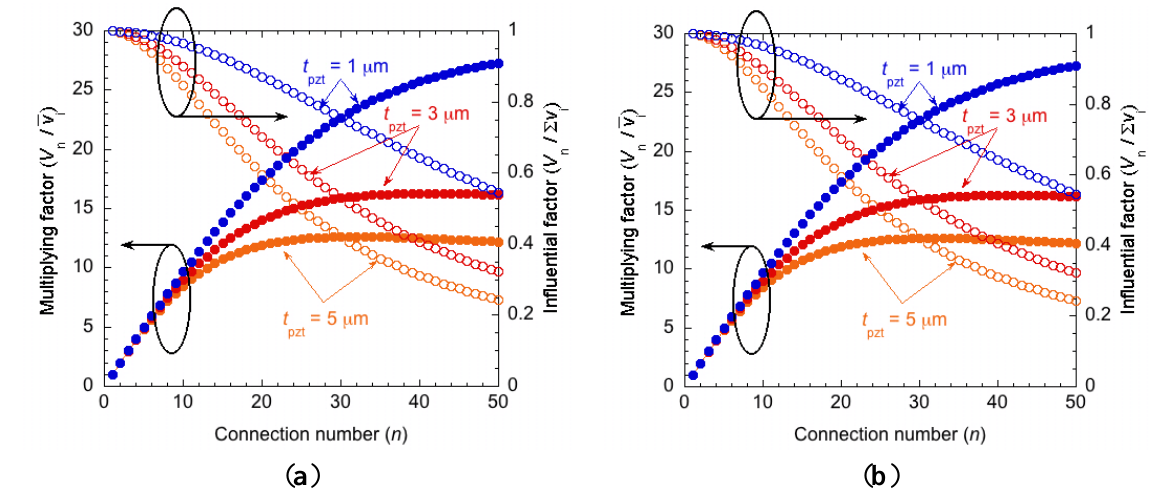
Figure 7. Influence of the parasitic capacitance. ( a ) Series-connected piezoelectric elements with bonding pads; ( b ) Series-connected piezoelectric elements with bonding pads and measurement